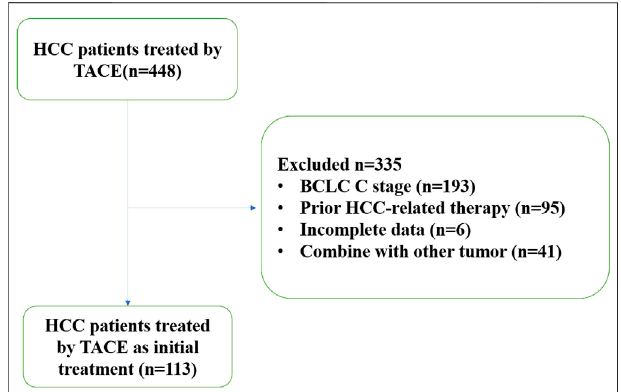
FIGURE 1 | Patient selection. HCC: hepatocellular carcinoma; TACE: transarterial